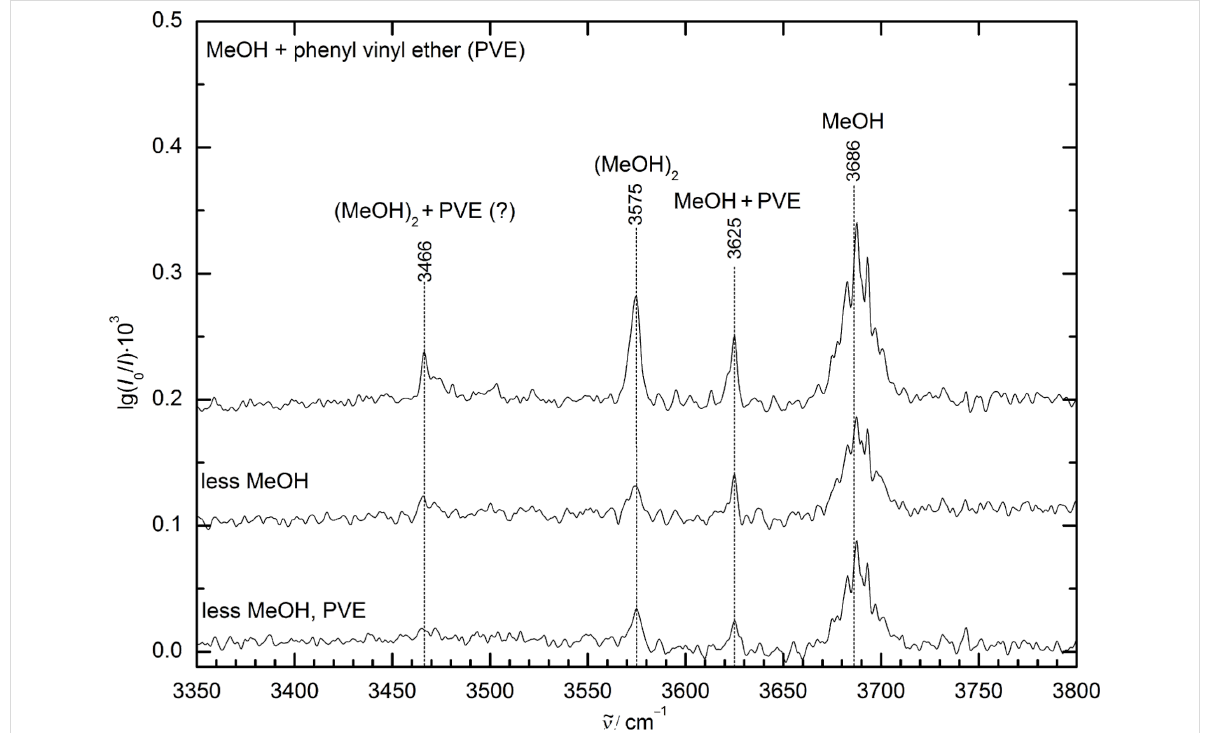
Figure 3: FTIR spectra of the supersonic expansion of methanol (MeOH) and phenyl vinyl ether (PVE) at different concentrations in helium. The spectra are spread out along the ordinate to improve visualization. Only one dominant mixed dimer band is visible in the spectra, lying at 3625 cm − 1 (marked MeOH + PVE) between the methanol monomer at 3686 cm − 1 (MeOH) and methanol dimer at 3575 cm − 1 ((MeOH) 2 ). By comparing the spec- trum at the top with the other two spectra recorded at reduced concentrations of methanol (middle) or methanol and PVE (bottom), the further down- shifted band at 3466 cm − 1 can be attributed to a higher cluster, probably a methanol-rich mixed trimer ((MeOH) 2 + PVE (?)), due to its scaling with the variation of the concentrations.